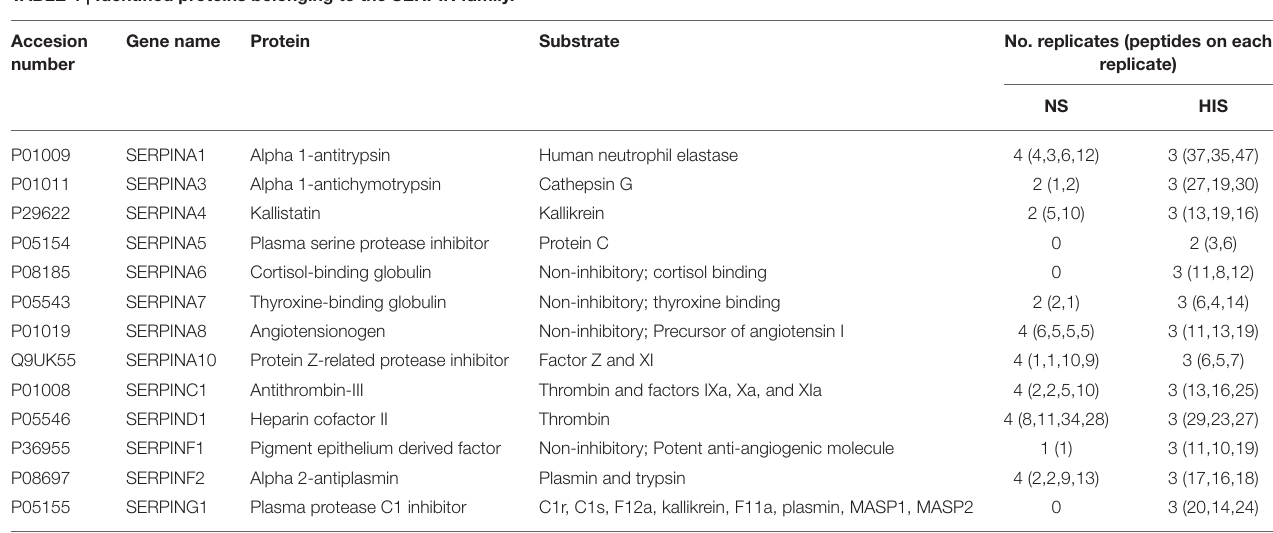
TABLE 4 | Identified proteins belonging to the SERPIN